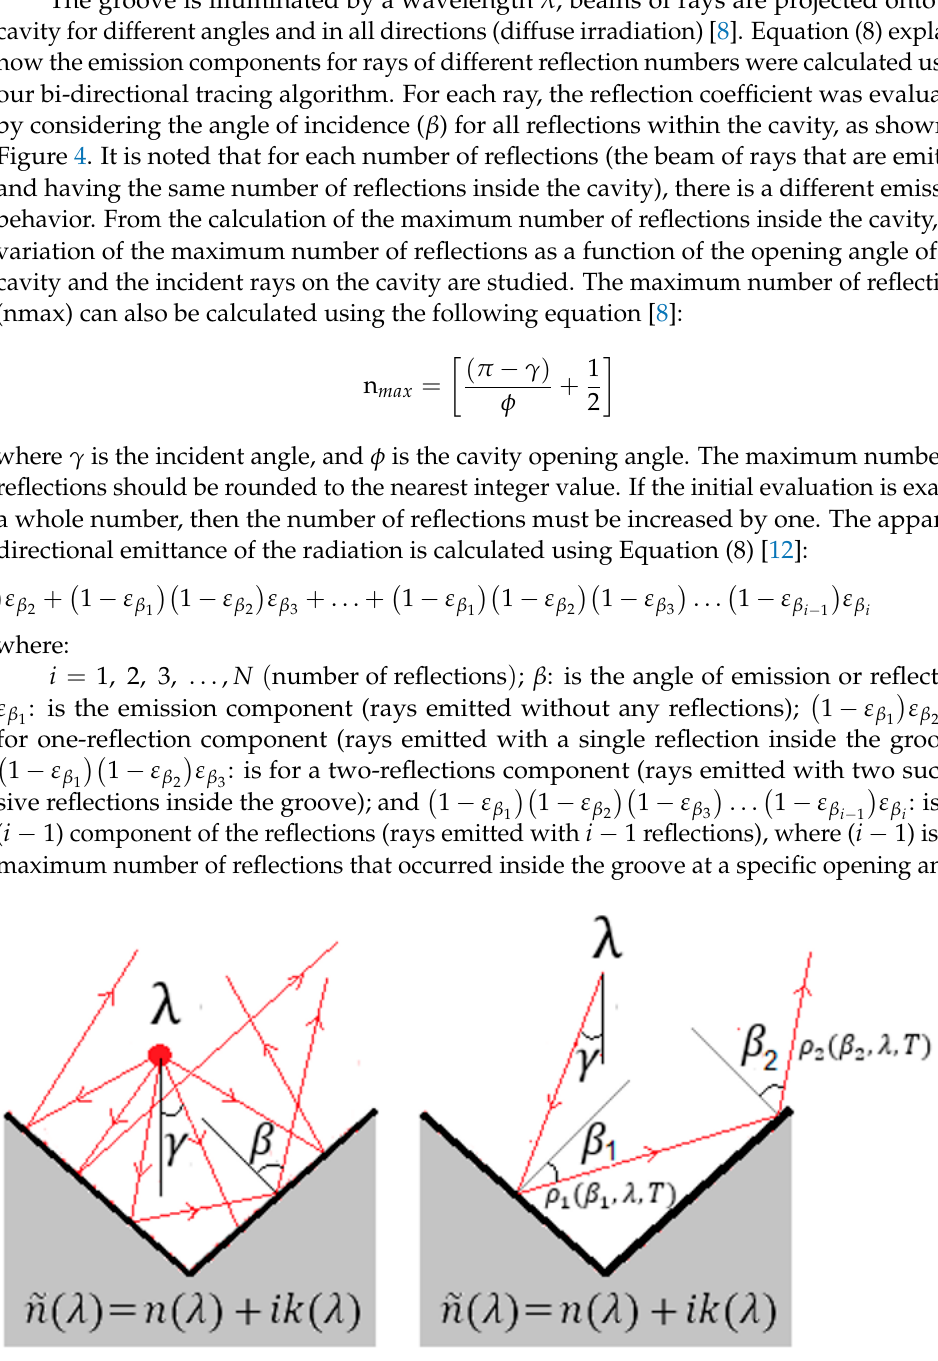
Figure 4. Geometric representation of the V-groove simulation.